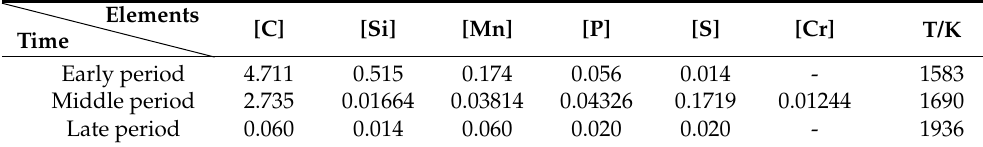
Table 4. Compositions of molten steel in the early, middle, and late periods in a heat melting (wt%). Elements [C] Time